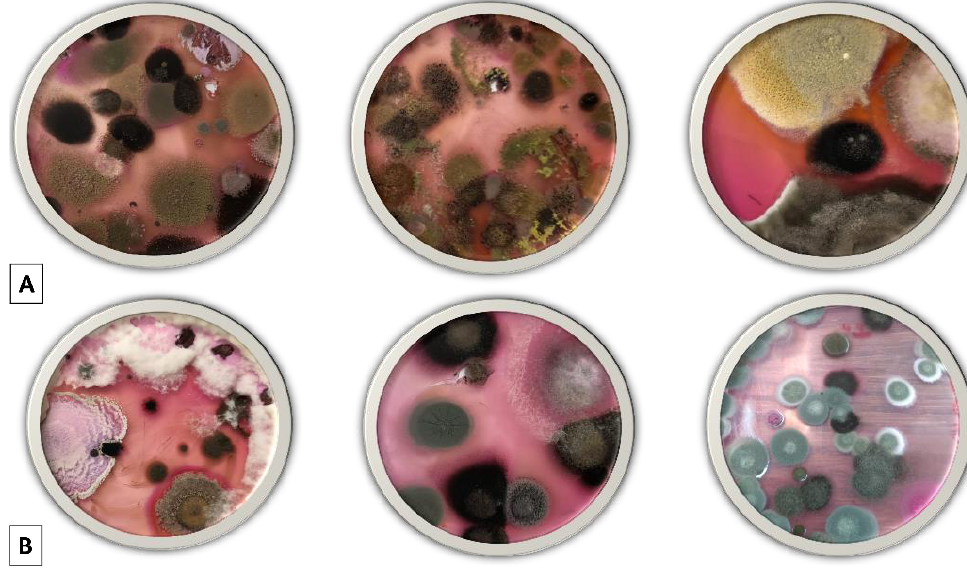
Figure 2. An example of the cultivated fungi on DRBC media from the current study. Plates from the reclaimed soil samples ( A ), and the desert soil samples ( B ).